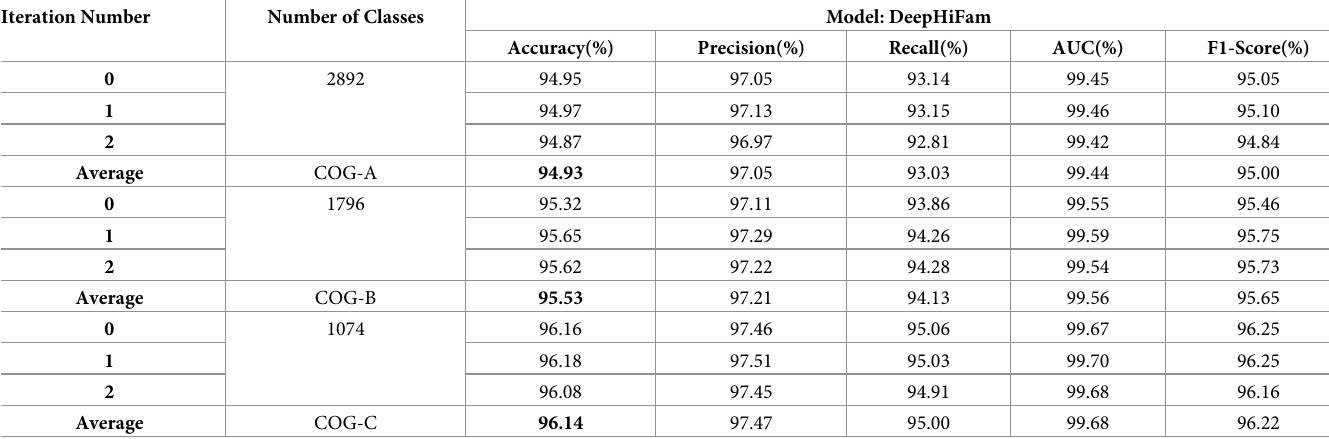
Table 3. 3-fold cross-validation results of COG A, B, and C dataset (see Table 1).